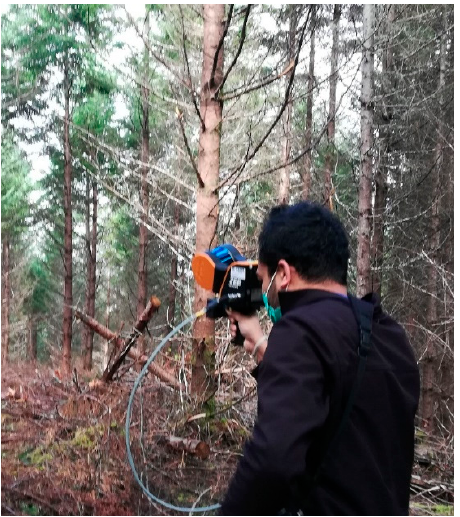
Figure 2. Scanning in McDonald research forest using the GeoSLAM Zeb Horizon.